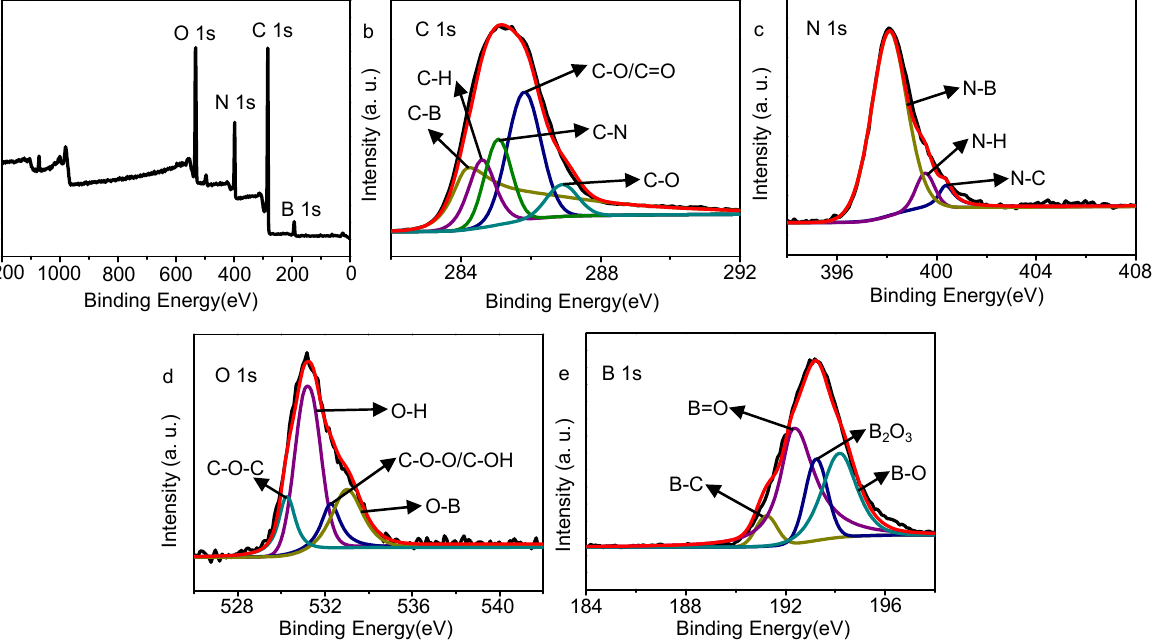
Figure 4. ( a ) Full X-ray photoelectron spectrum of o-GQDs, ( b ) C1S spectrum measured by X-ray photoelectron spectrum of o-GQDs, ( c ) N1s spectrum of o-GQDs, ( d ) O1s spectrum of o-GQDs, and ( e ) B1s spectrum of o-GQDs.